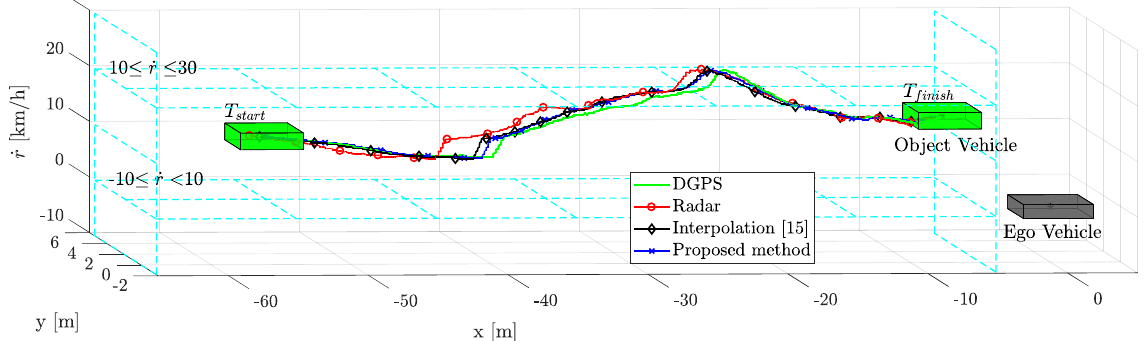
Figure 9. Scenario-based relative movement of object estimation with relative speed in a 3D